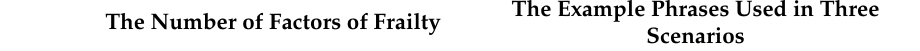
Table A1. Criteria to define di ff erent stage of frailty of a cancer patient. The Example Phrases Used in The Number of Factors of Frailty